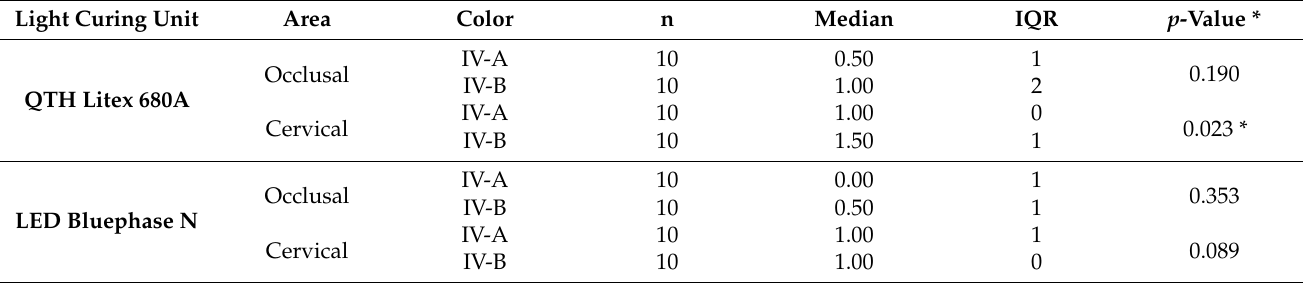
Table 5. Microleakage of dental restorations according to shade of bulk-fill resin